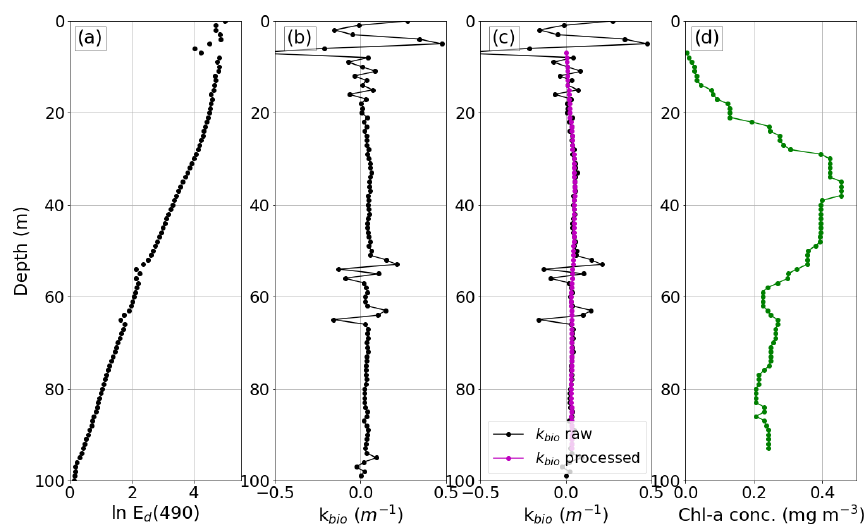
Figure A1. (a) Profile of ln E d (490) from dive 10, float 631, interpolated onto a 1m vertical grid. (b) The attenuation due to biological constituents, K bio (m − 1 ). (c) K bio (m − 1 ) before quality control processing (black dotted line) and after quality control processing (magenta dotted line). (d) Chlorophyll a concentration (mgm − 3 ) (green dotted